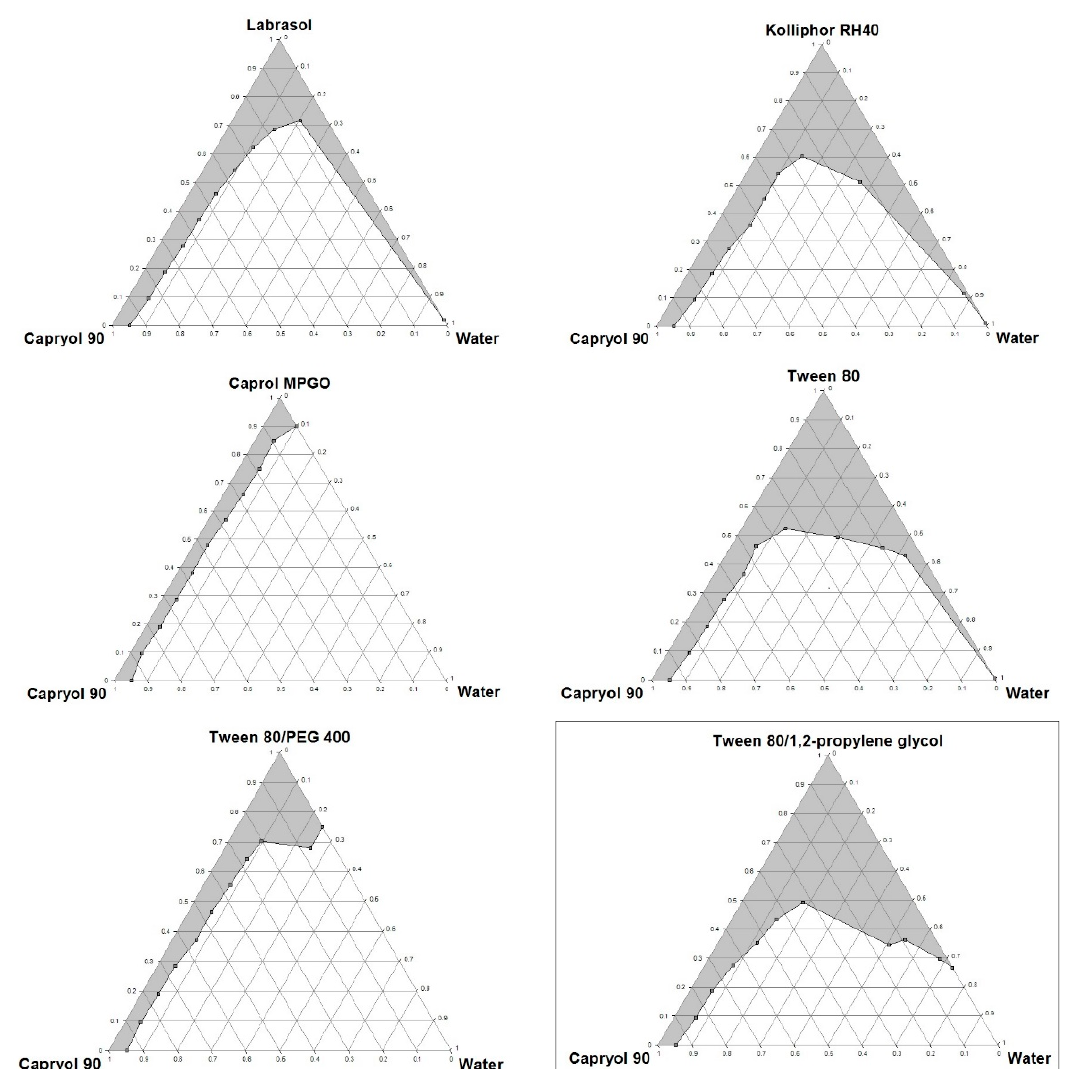
Figure 2. Pseudoternary phase diagrams of mixtures with Capryol 90. Tween 80/PEG 400 and Tween 80/1,2-propylene glycol ratio is 1:1. The diagram with the formulation characterized by the best self-emulsifying properties is framed.